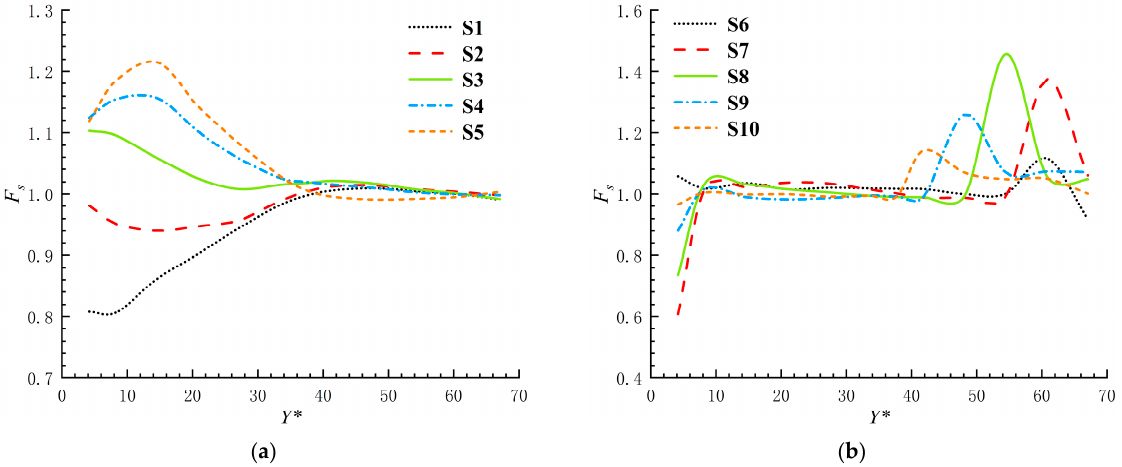
Figure 12. Cross-sectional averaged streamwise concentration flux along the channel. ( a ) Case S1–S5; ( b ) and Case S6–S10.